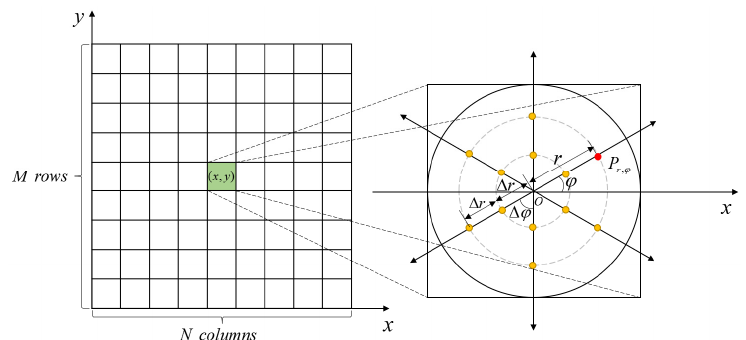
Figure 3. The calculation method of the radius. The detection radius of different points is shown in Figure 4. The warmer the color of the grid, the larger the detection radius, and vice versa.